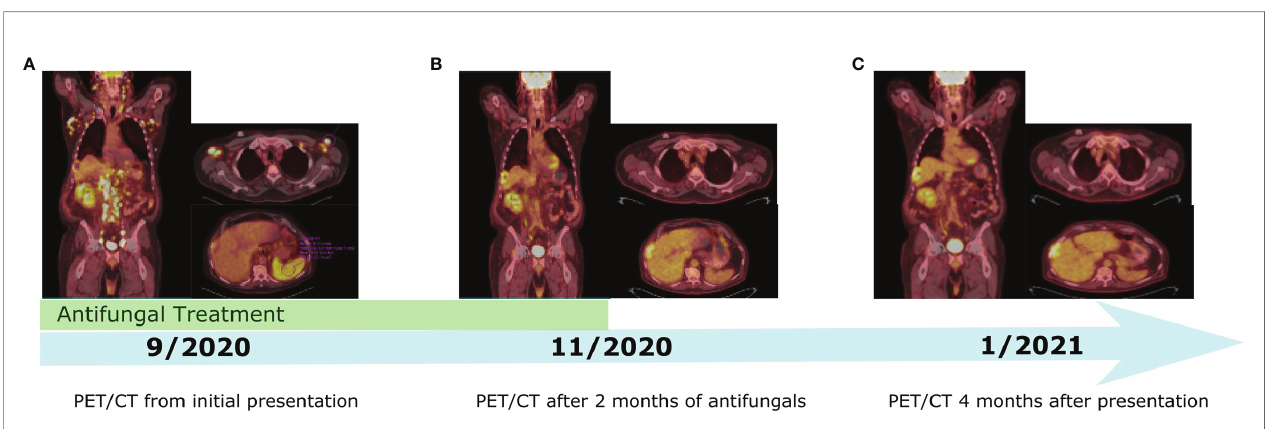
FIGURE 1 | Timeline of PET/CT imaging throughout the patient's course. (A) PET/CT from Initial presentation with fever and diffuse FDG avid lymphadenopathy. (B) PET/CT showing signi fi cant decrease in size and metabolic activity of previously enlarged lymph nodes after two months of antifungal treatment. (C) PET/CT showing complete resolution of lymphadenopathy 4 months after initial